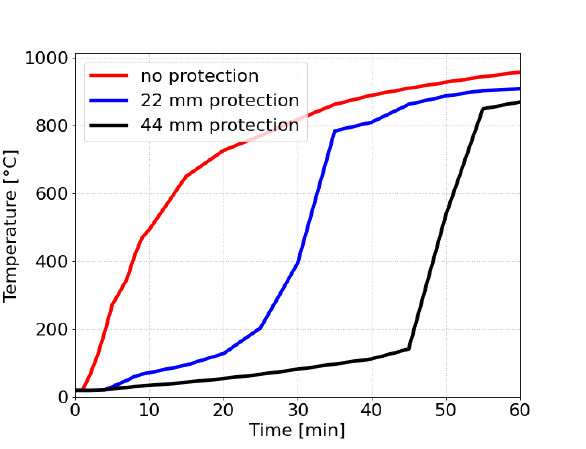
Figure 5. Temperature comparison of the unpro- tected and protected steel beams.